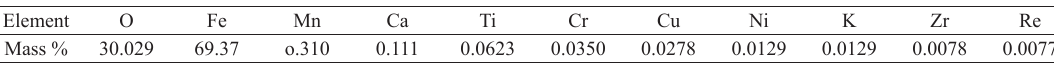
Table 1. Average chemical composition of the tested hot-rolled mill scale.